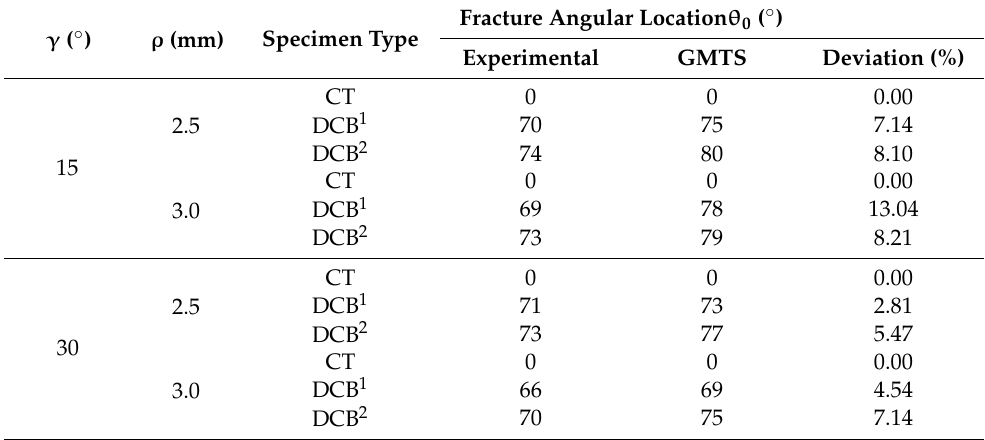
Table 4. Comparison between the average experimental fracture angle and GMTS estimations.